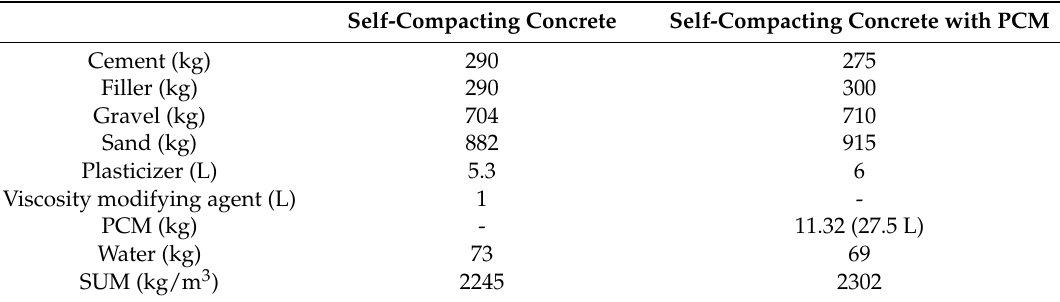
Table A1. Cubicle panels